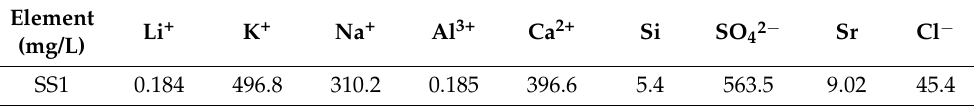
Table 4. Ion chemical composition (mg/L) of SS1 extract solution reported by Laboratory of Chemical Analysis (Cinvestav-Saltillo, Mexico) and Ion selective electrode (Cl-ion). Element Li + K + Na + Al 3+ Ca 2+ Si SO 42 − Sr Cl − (mg/L) SS1